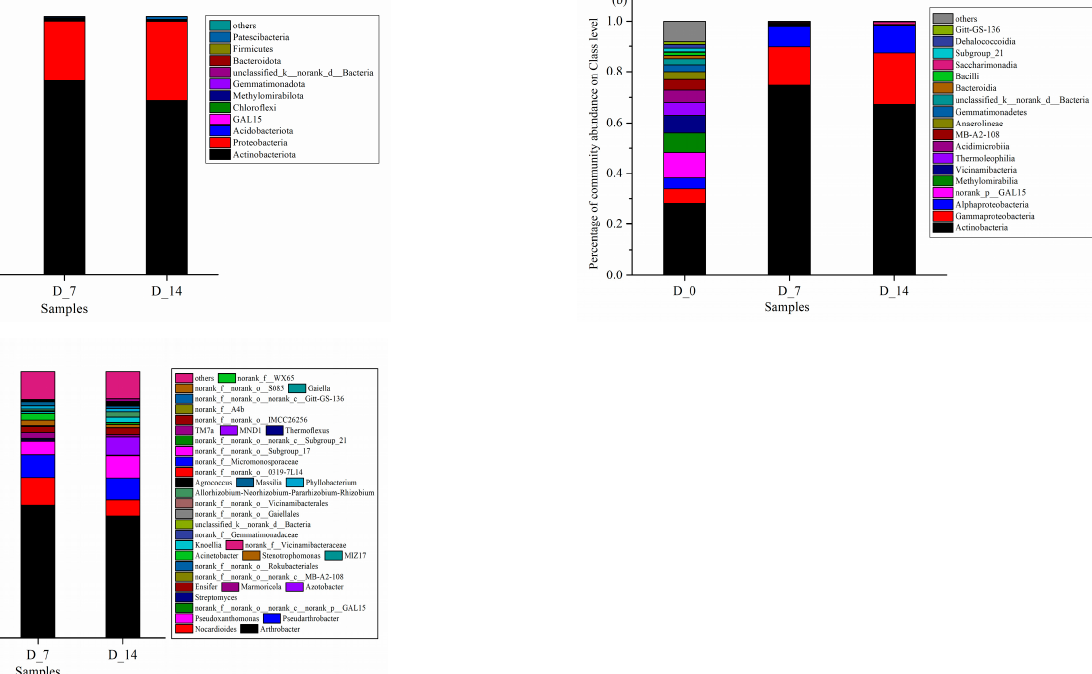
Figure 5. Community composition of bacteria at phylum level ( a ), class level ( b ), and genus level ( c